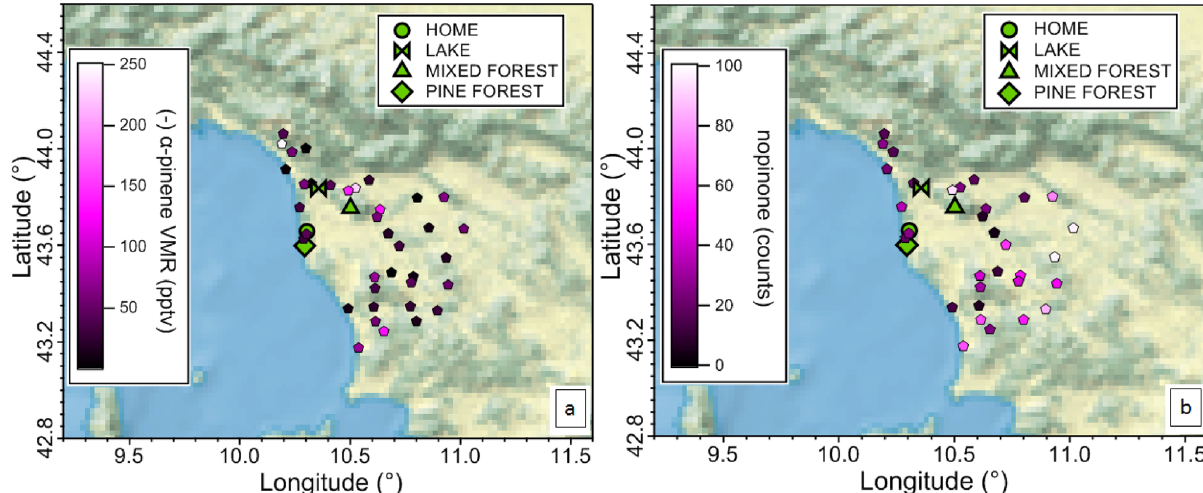
Figure 5. Spatial distributions of measured (−)α-pinene ( a ) and nopinone ( b ) from airborne sampling during three flights conducted on 26/05/2018 and 27/05/2018. Colored scales indicate respectively volume mixing ratio and counts of chromatograms peak area. Figures drawn with Igor WaveMetrics.